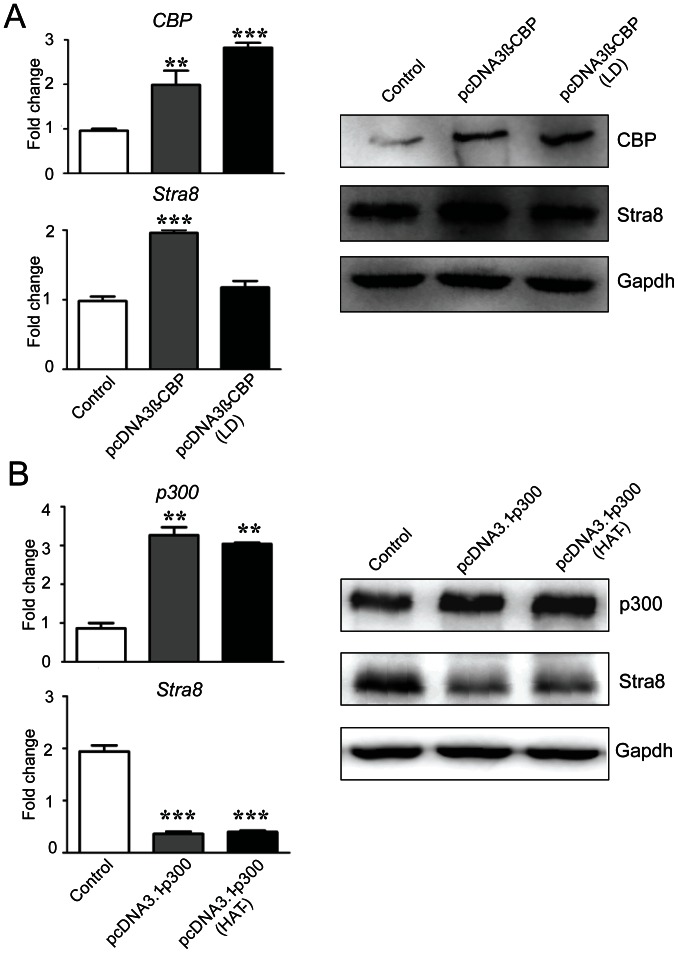
The activation of the Stra8 gene by CBP requires its HAT activity, while p300 represses Stra8 expression through a HAT-independent mechanism.(A) Real-time PCR and Western blot analysis of the expression of Stra8 in ESCs after transfection with pcDNA3ß-CBP or pcDNA3ß-CBP (LD) and treatment with RA for 24 h. (B) Real-time PCR and WB to analyze the Stra8 expression in ESCs after transfection with pcDNA3.1-p300 or pcDNA3.1-p300 (HAT-) and treatment with RA for 24 h. In Real-time PCR analysis of Figure 3, the mRNA expression levels were normalized to Gapdh and presented as fold change over control set. Data are means ± SEM (n = 3). P<0.01(**) and P<0.001(***) vs. control ESCs (One-way ANOVA with Turkey-Kramer post hoc test).